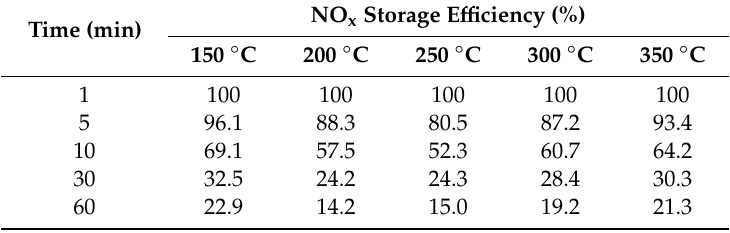
Table 5. NO x storage e ffi ciency of Mn15 sample at di ff erent temperatures.